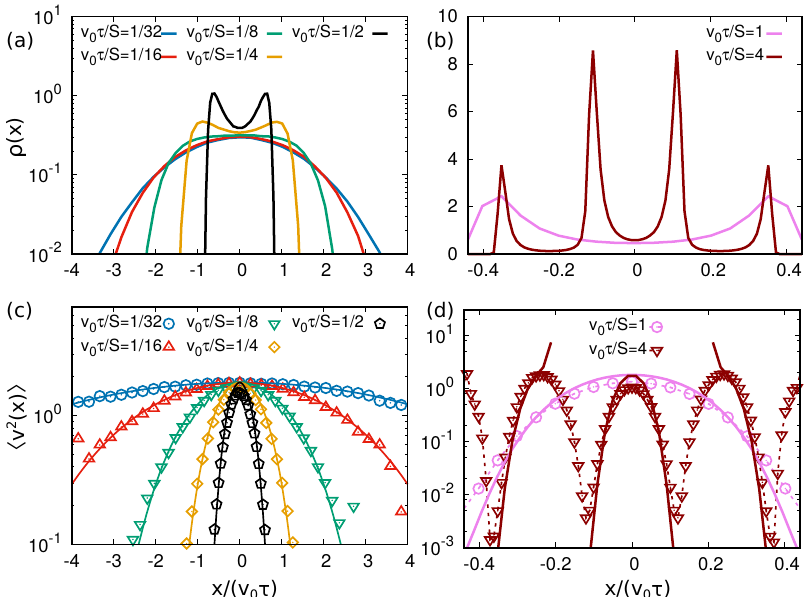
Figure 4: Spatial profiles of the kinetic temperature. Panels (a) and (b): simulated τ/ S as a density profile ρ ( x ) for different values of the dimensionless parameter v 0 reference. Panels (c) and (d): kinetic temperature 〈 v 2 ( x ) 〉 with the same color leg- τ/ S ≤ 1, end. In particular, panels (a) and (c) show the small-persistence regime, v 0 while panels (b) and (d) display the intermediate-persistence and large-persistence τ/ S ∼ 1 and v τ/ S ≥ 1, respectively. Colored symbols (and regimes, namely v 0 0 dotted lines drawn as a guide to the eye) are obtained from numerical simulations while solid colored lines show the theoretical prediction (11) (in the regions where Λ ( x ) , given by Eq. (19), is positive definite). Simulations are realized in one spatial dimension with τ k /γ = 1 and α =